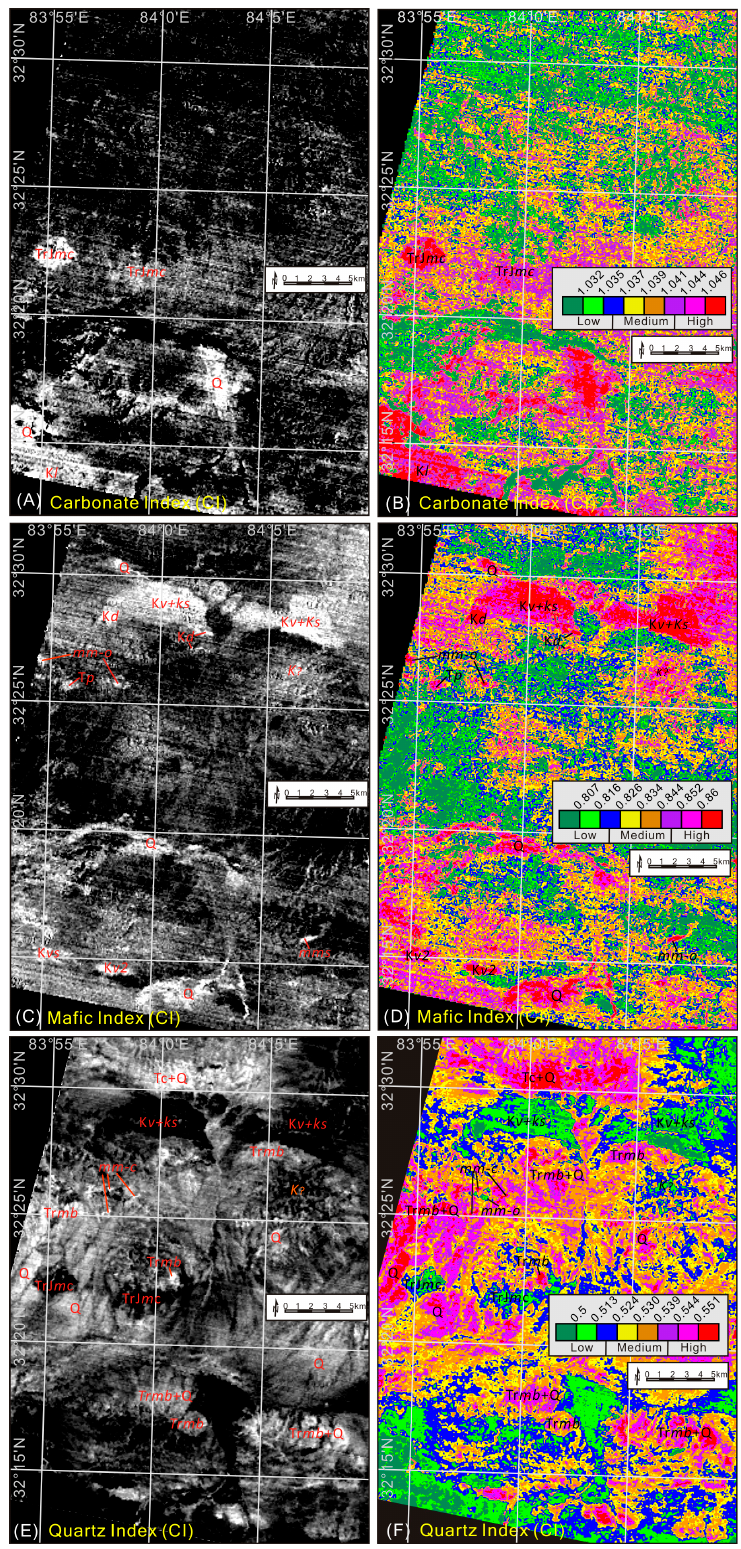
Figure 9. Grayscale and classified color images of the TIR indexes: ( A , B ) Carbonate index (CI); ( C , D ) Mafic index (MI 4 ); ( E , F ) Quartz Index (QI). See text and Figure 8 for interpretation of the labels of lithologic units.